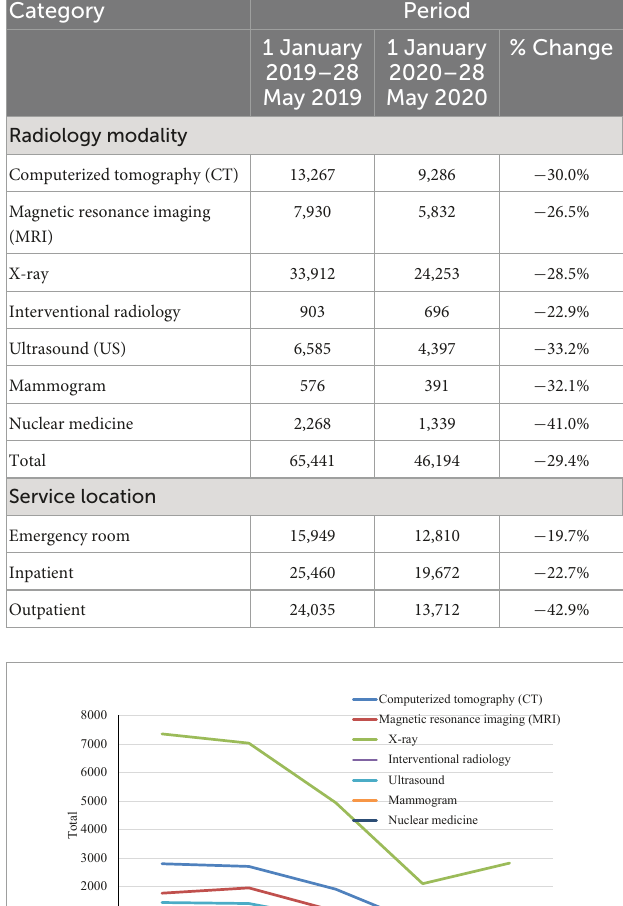
TABLE 1 The change in imaging case volumes between the two study periods (1 January 2020–28 May 2020, vs. 1 January 2019–28 May 2019) according to the radiology modality and patients’ service location.